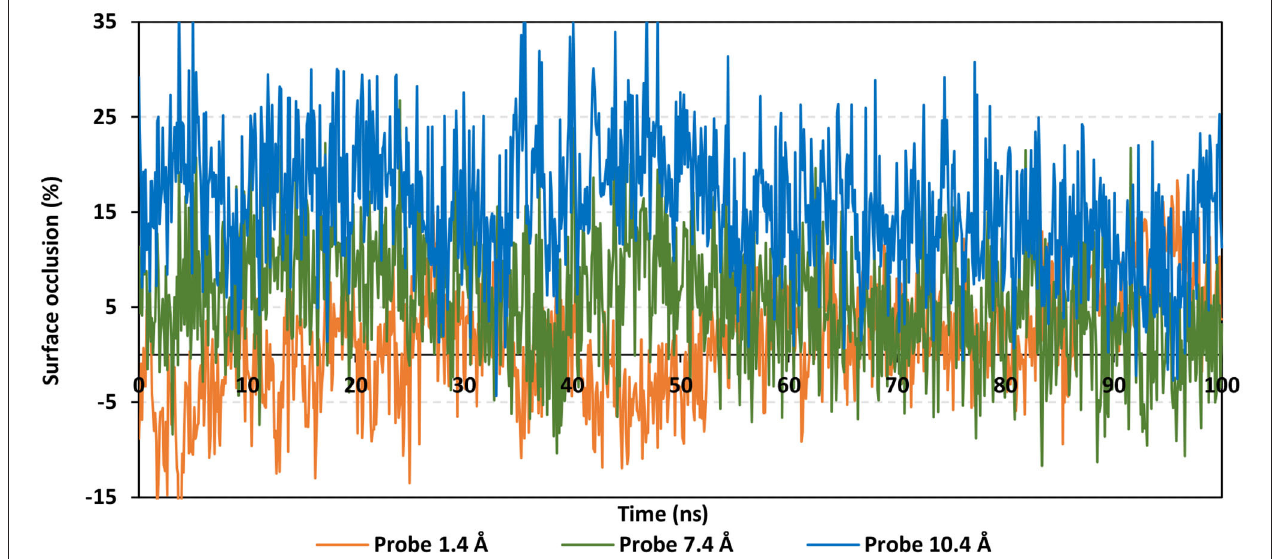
FIGURE 8 | Extent of h ACE2 binding site coverage via SASA analysis along with the time evolution 100 ns all-atom MD simulation. Surface occlusion is defined as the surface percentage being covered via NAG being calculated relying on the SASA differences for the binding site surface in the presence and absence of NAG glycans. Three different probe sizes (1.4, 7.2, and 10 Å) were utilized for calculating the SASA values. Data are represented as % surface occlusion vs. the MD simulation time in nanoseconds.